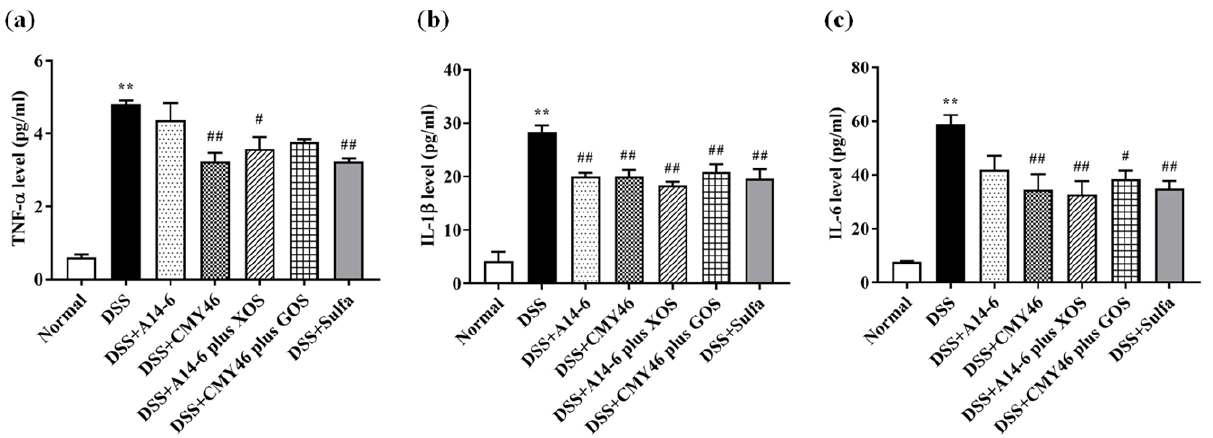
Figure 7. The effects of probiotics and synbiotics from Miang on DSS-induced systemic inflammation. The serum levels of ( a )TNF- α ; ( b ) IL-1 β ; ( c ) IL-6. Data are expressed as mean ± SEM ( n = 4), ** p < 0.01 vs. normal group. # p < 0.05; ## p < 0.01 vs. DSS group.